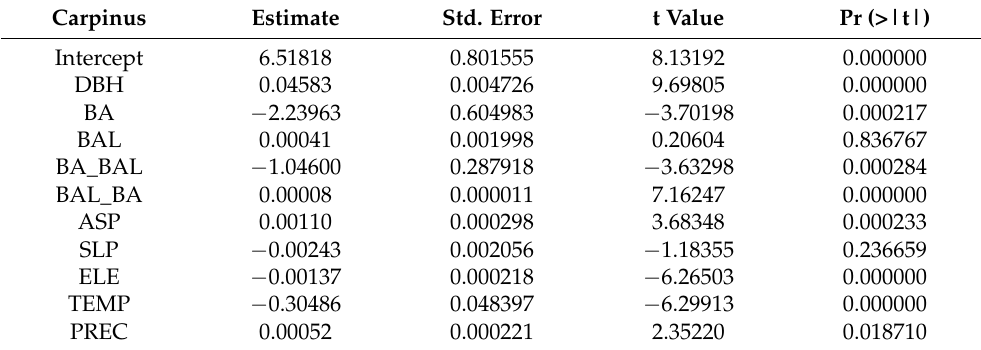
Table 2. Results of the linear mixed-effect model for Carpinus diameter increment.